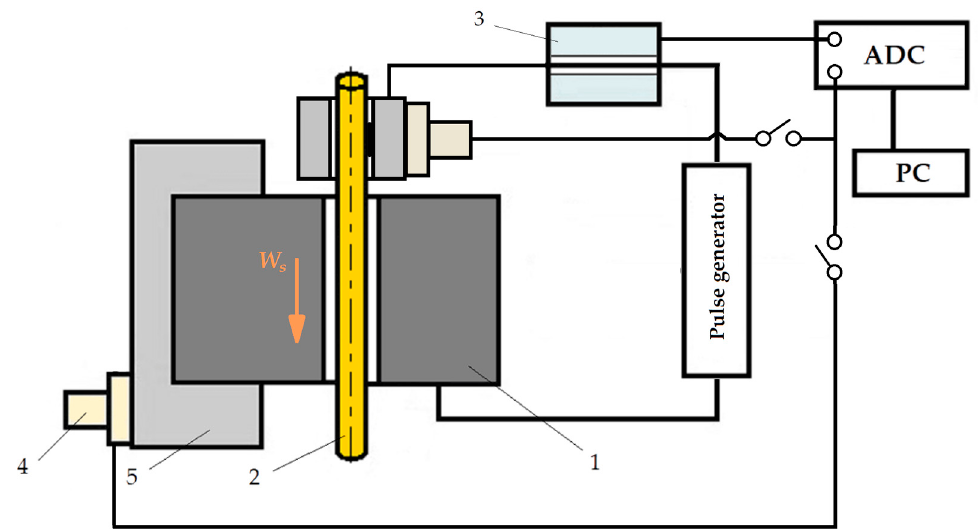
Figure 2. Scheme of monitoring sensor setup at electrical discharge machine: ( 1 ) is a workpiece; ( 2 ) is a wire tool; ( 3 ) is a current sensor; ( 4 ) is accelerometers; ( 5 ) is a workpiece fastening system; ADC is the analog-digital converter; PC is a personal computer.